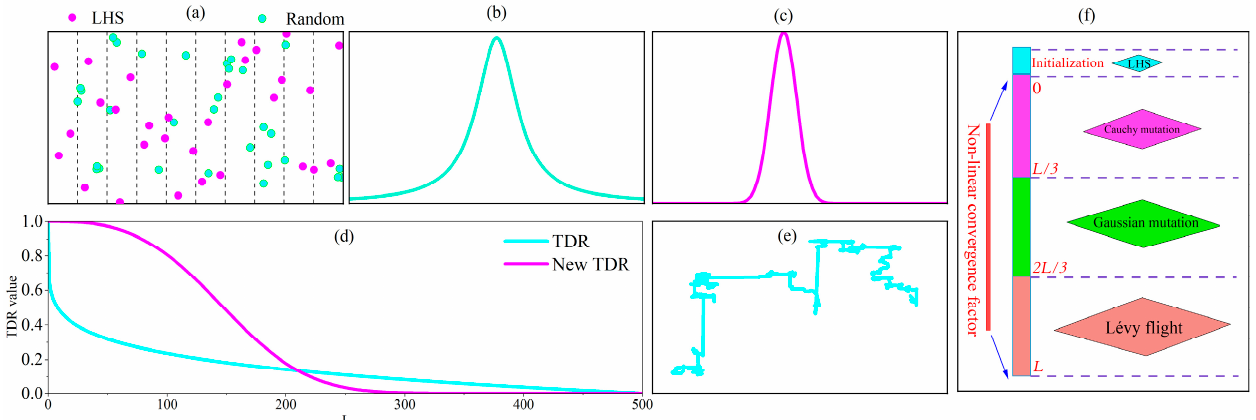
Figure 8. ( a ) Comparison of methods for population initialization distribution, ( b ) Cauchy mutation, ( c ) Gaussian mutation, ( d ) Nonlinear convergence factor, ( e ) Lévy flight and ( f ) Schematic of the MDMVO algorithm.